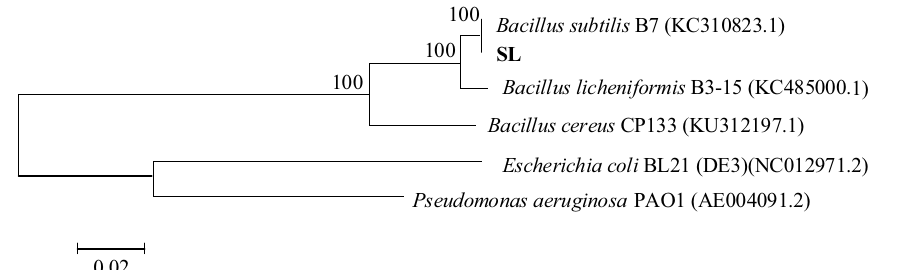
Figure 2. Phylogenetic tree of strain SL based on 16S rDNA sequences of closely related